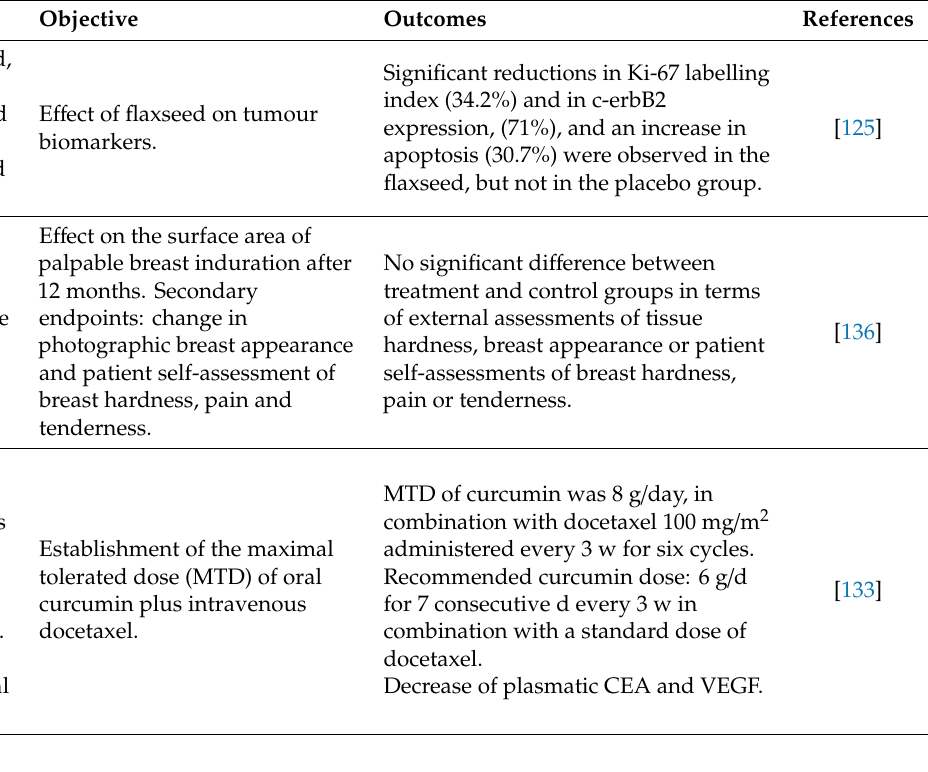
Table 3. Clinical trials with dietary (poly)phenols or phenolic-containing foodstu ff s in patients with breast